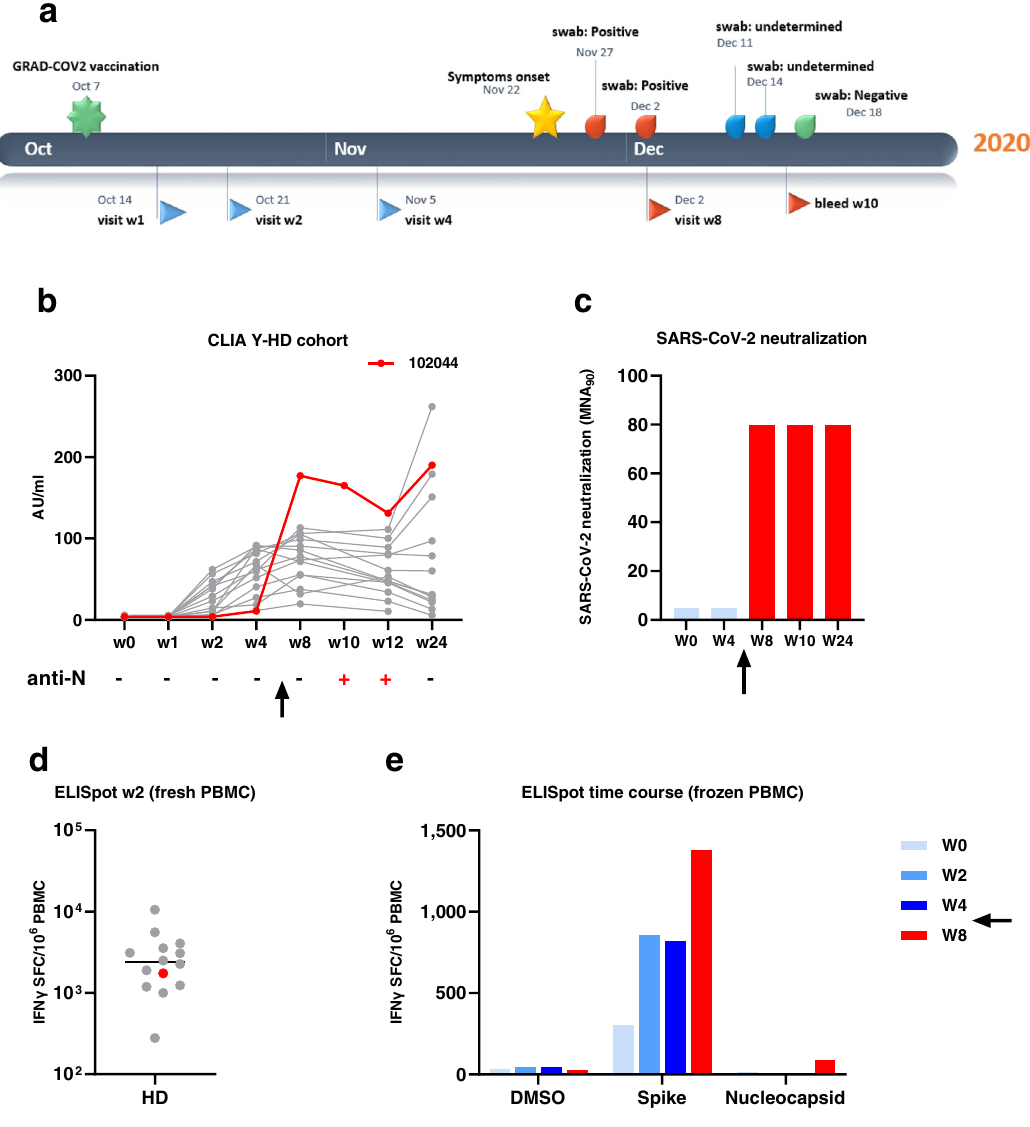
Fig. 2 Immune response before and after SARS-CoV-2 infection in a GRAd-COV2 vaccinated volunteer. a Timeline detailing the SARS-CoV- 2 infection case in terms of vaccination, in-study and out-of-study visits, symptoms onset and swabs outcome until resolution. b IgG binding to S1-S2 measured by CLIA in arm 3 (high dose vaccine in younger age volunteers), with IgG kinetics in the COVID-19 case depicted in red and all remaining volunteers in gray for context. Below each study visit indicated on x axis, the outcome of a qualitative CMIA detecting anti- nucleocapsid (N) IgG is reported for the COVID-19 case. c SARS-CoV-2 neutralizing activity time course in serum from the COVID-19 case, detected by MNA. d T cell response to Spike in arm 3 detected by IFN γ ELISpot on freshly isolated PBMC 2 weeks after vaccination, with the COVID-19 case depicted in red and all remaining volunteers in gray for context. The horizontal line is set at median. e Spike and N T-cell response time course in the COVID-19 case, detected by IFN γ ELISpot on frozen PBMC. DMSO, the peptide pools diluent, represents the assay negative control. The arrow in panels b , c and e highlight timing of SARS-CoV-2 infection. Postinfection visits data in panels c and e are depicted in